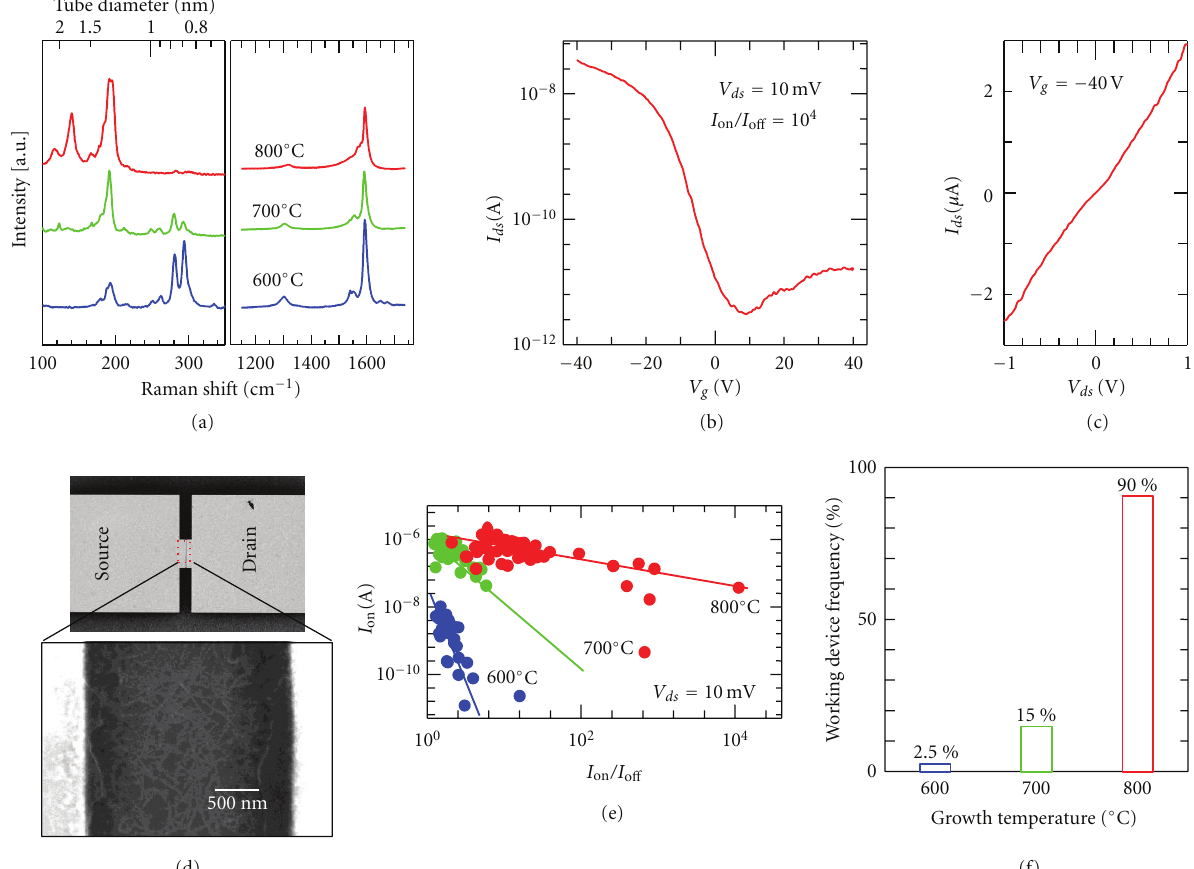
Figure 6: (a) Raman scattering spectra of SWNTs grown at di ff erent growth temperatures. (b) I ds - V g and (c) I ds - V ds characteristics of TFT devices fabricated with SWNTs grown at 800 ◦ C. (d) Typical SEM image of TFT devices with random-network SWNTs grown at 800 ◦ C. (e) I on - I on / I o ff plot of TFT devices with SWNTs grown at di ff erent growth temperatures. (f) Histogram of working device concentration for TFT devices with SWNTs grown at di ff erent growth